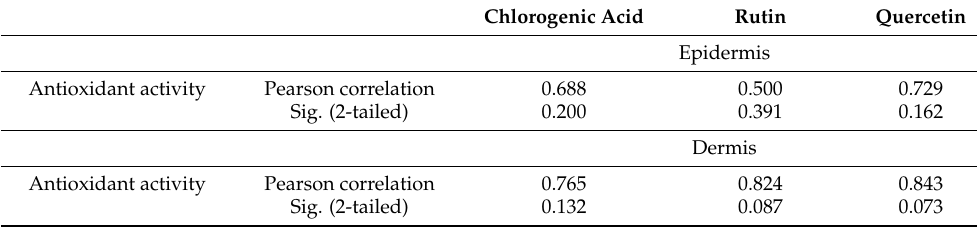
Table 2. Correlation between individual phenolic compounds penetrated into the skin layers and the antioxidant activity detected in these skin